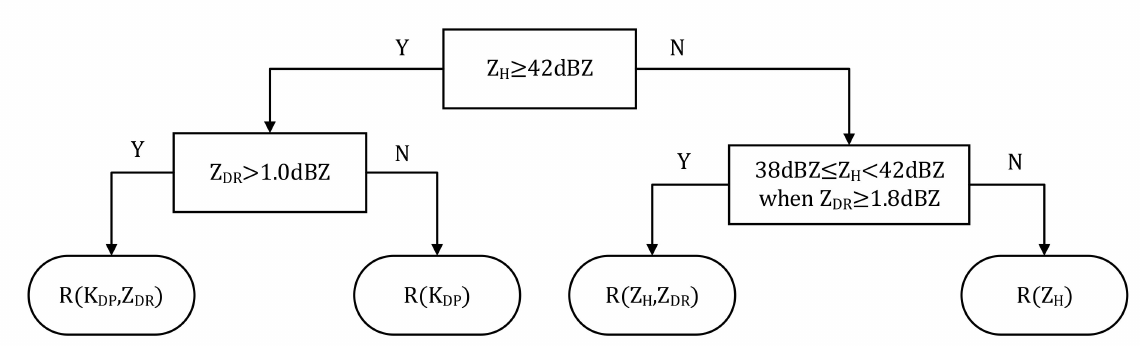
Figure 4. Flowchart description of the 2DVD-SCM QPE